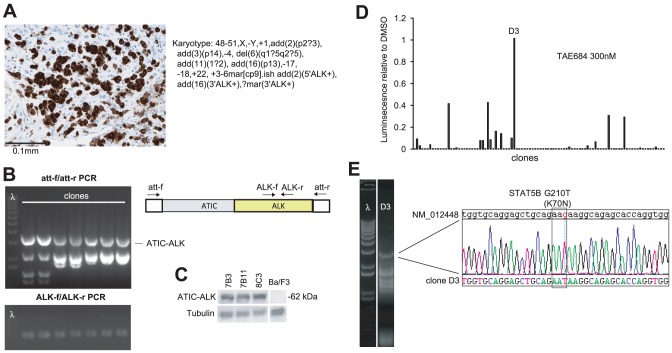
cDNA library screening identified an ALK translocation partner and resistance allele.
A. Immunohistochemistry using an antibody against ALK and karyotype of the anaplastic large cell lymphoma specimen 421. B. Multiple IL3-independent clones were recovered from screening of the cDNA library generated from 421, all of which contained ALK cDNA using primers within the flanking attB sites or within ALK itself. C. Immunoblot using antibody against ALK demonstrates ATIC-ALK expression in multiple clones but not in wild-type Ba/F3 cells. D. Effect on proliferation of 96 individual clones recovered from the 421 library with TAE684 300 nM, quantified using the ATP chemiluminescent agent CellTiterGlo. E. PCR amplification using the att-f and att-r primers with DNA from clone D3 demonstrates a full-length STAT5B allele that harbored a G210T (K70N) mutation.